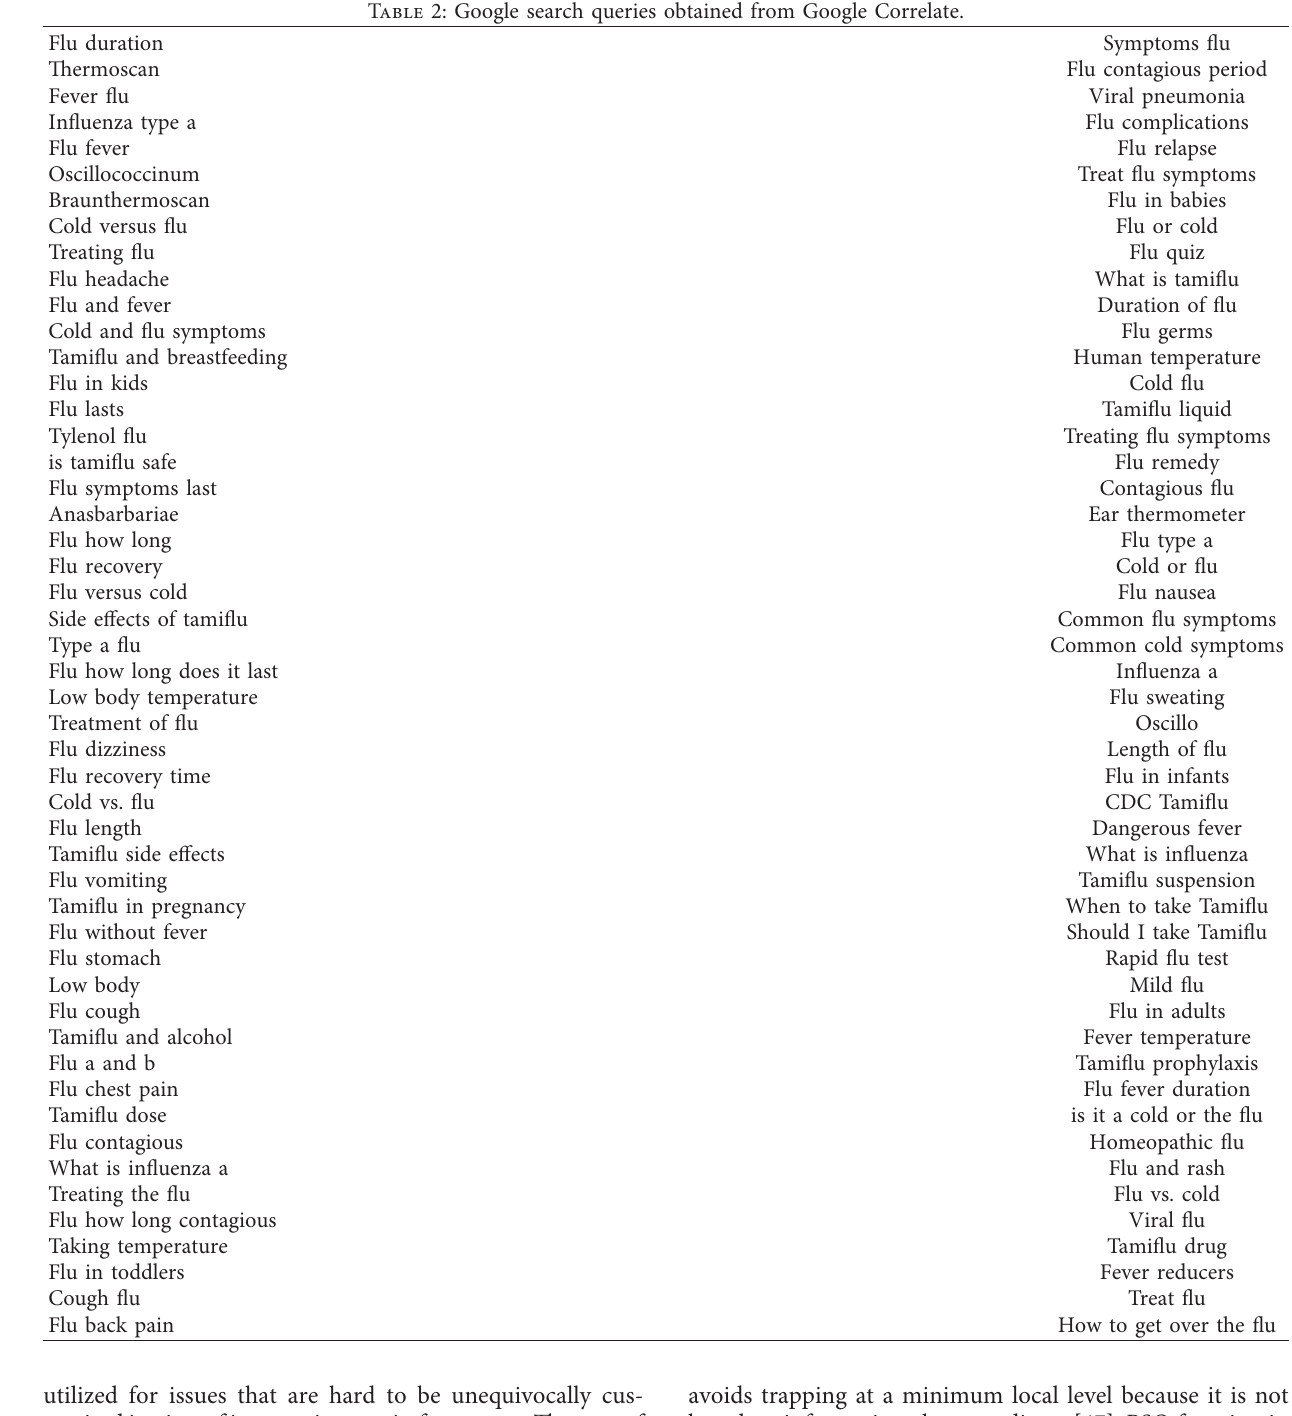
Table 2: Google search queries obtained from Google